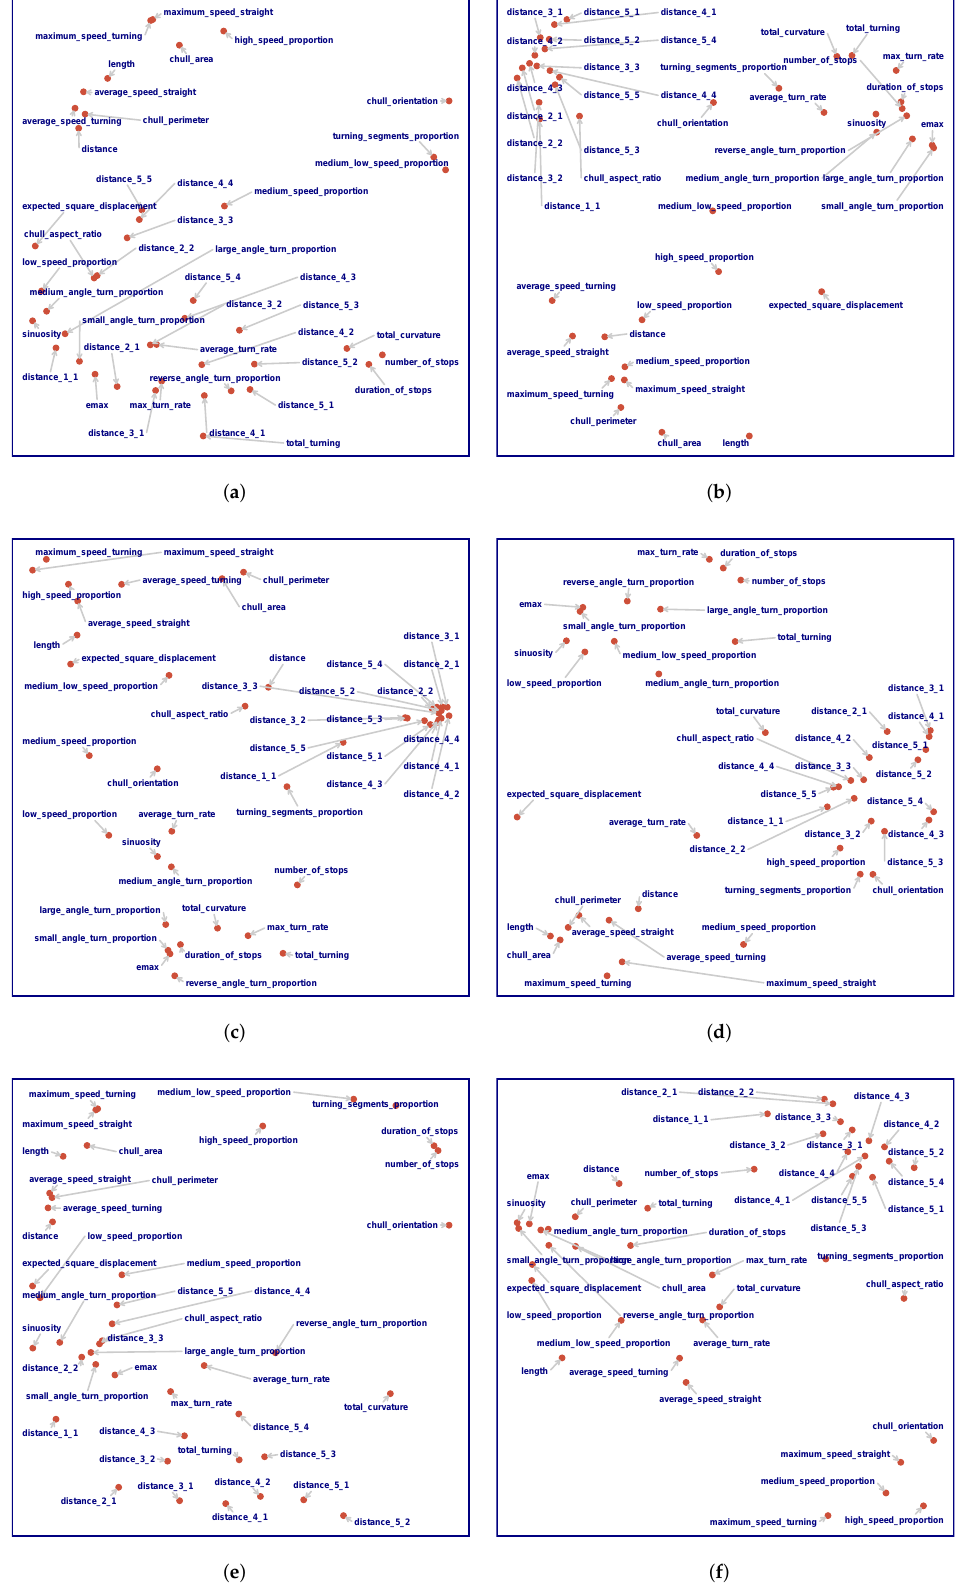
Figure 14. The 2D multidimensional scaling of the descriptors using data points that belonged to each: ( a ) cargo ships; ( b ) fishing ships; ( c ) passenger ships; ( d ) sailing ships; ( e ) tankers; ( f ) towing